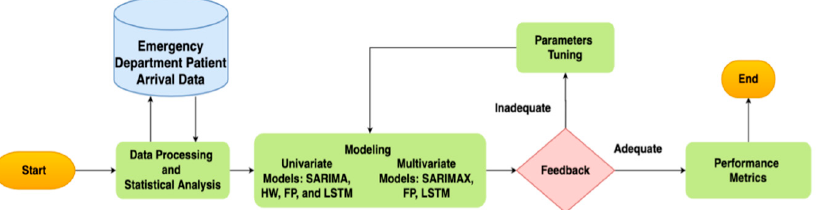
Figure 1. Forecasting modeling framework for ED patient arrivals. The proposed method has three main parts: data processing/statistical analysis, model building, and